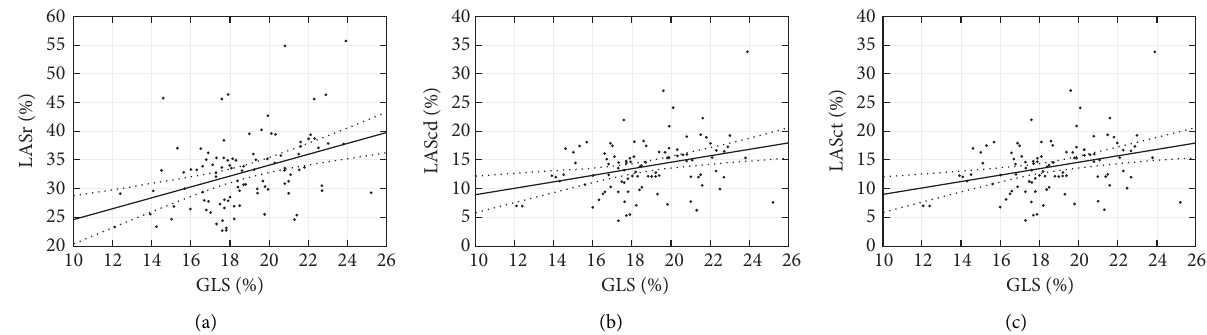
Figure 2: Correlations plots for GLS versus LASr ( R � 0.37; p < 0.001, left chart), GLS versus LAScd ( R � 0.29, p < 0.01; middle chart) and GLS versus LASct ( R � 0.18, ns; right chart) (LAScd, left atrial strain conduit; LASct, left atrial strain contraction; LASr, left atrial strain reservoir; and GLS, left ventricular global longitudinal strain).